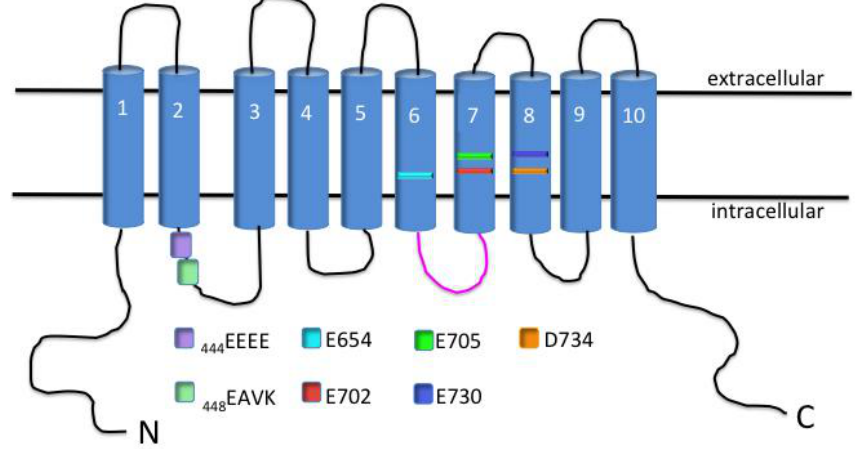
Figure 2. Schematic of TMEM16A channel protein with identified residues necessary for voltage and Ca 2+ -sensitivity. TMEM16A channel protein consists of 10 transmembrane domains (TMD). The intracellular loop between TMD-2 and TMD-3 contains the voltage-sensitive 444 EEEE residues, as well as the 448 EAVK residues that participate in Ca 2+ -sensitivity of the channel. The E702 and E705 residues located within the seventh TMD also participate in Ca 2+ -sensitivity of the channel. The third intracellular loop (shown in pink), and the residues E654, E730 and D734 have also been implicated to affect Ca 2+ -sensitivity of the channel.